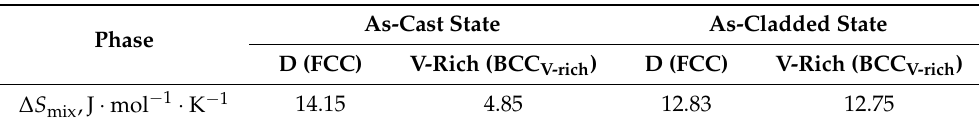
Table 2. The entropy of mixing for each of the phases of Al 0.25 CoCrFeNiV HEA in as-cast and as-cladded